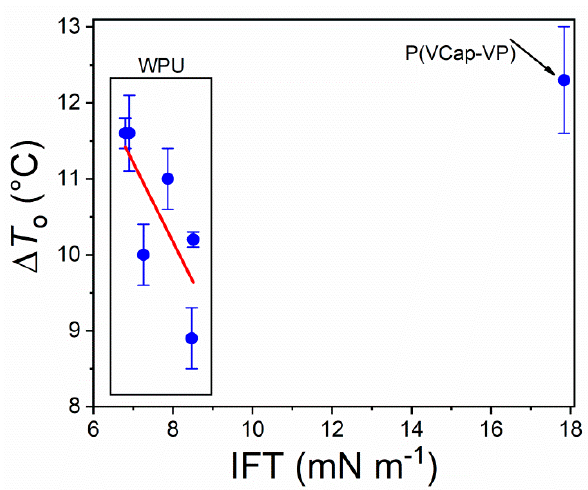
Figure 5. Dependence of the hydrate onset subcooling ∆ T o on the interfacial tension IFT for the samples at 0.25 wt%.